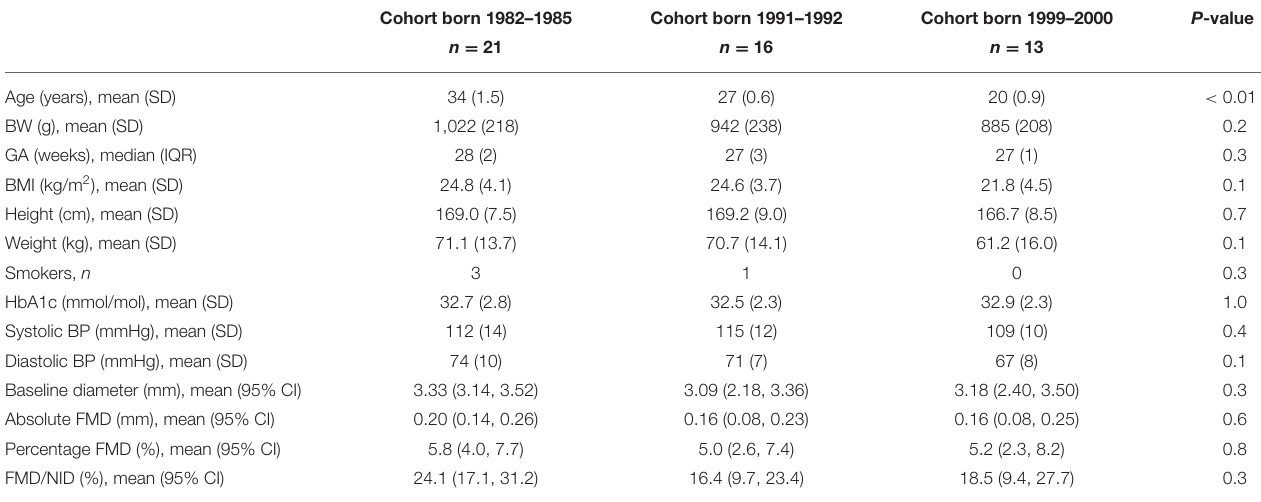
TABLE 3 | Characteristics of participants born very preterm or with extremely low birthweight, by